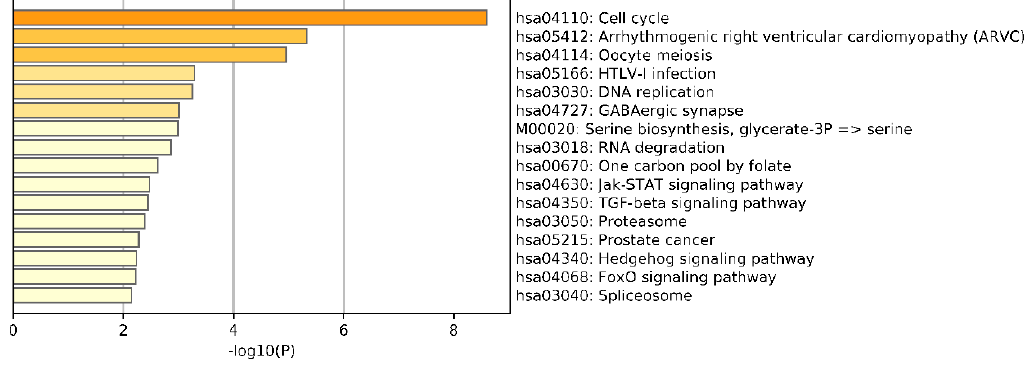
Figure 12. Bar graph of enriched pathways, colored by p -values.